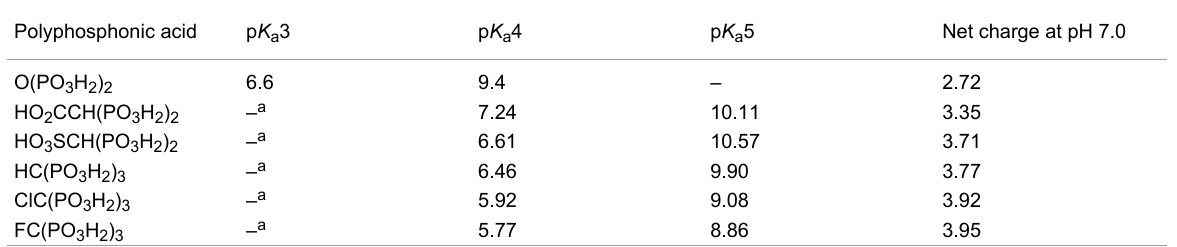
Table 1: Ionisation constants for polyphosphonic acids determined in the range 3.5 < pH < 10.5 at 37 °C and 0.152 M NaCl [7].